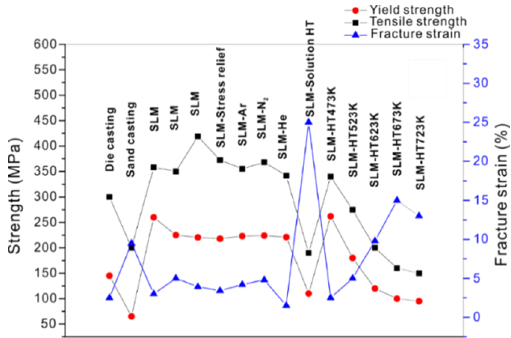
Figure 58. Comparison of the tensile properties of Al-12Si alloy produced by die-casting, sand casting and various SLM processes with/without heat treatments. Table 3. Summary of the tensile properties of Al-12Si